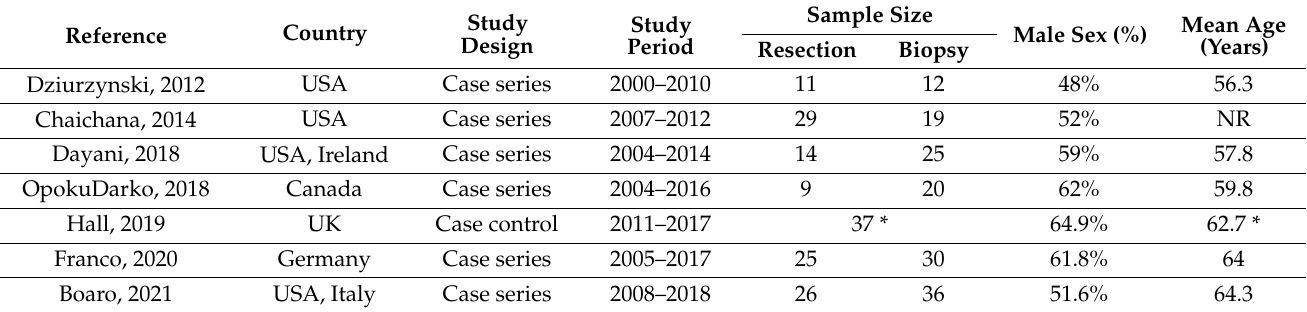
Table 1. Study characteristics of included articles.